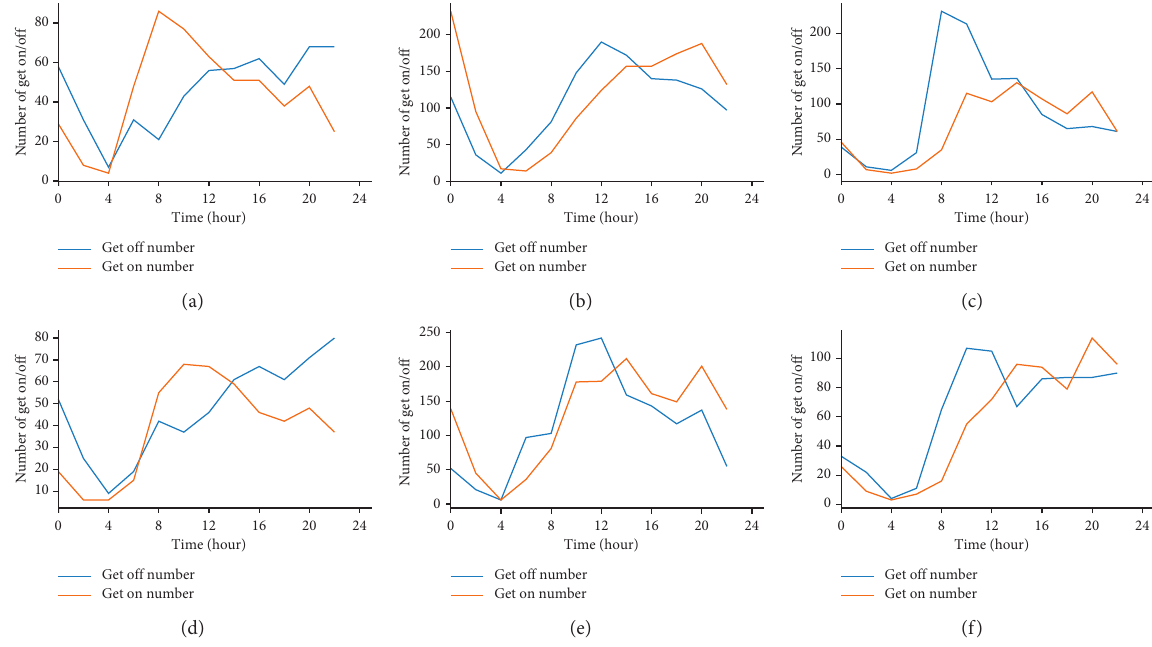
Figure 3: Relationship between getting on and getting off on weekdays and weekends in different regions. (a) Residential area weekday. (b) Commercial area weekday. (c) Working area weekday. (d) Residential area weekend. (e) Commercial area weekend. (f) Working area